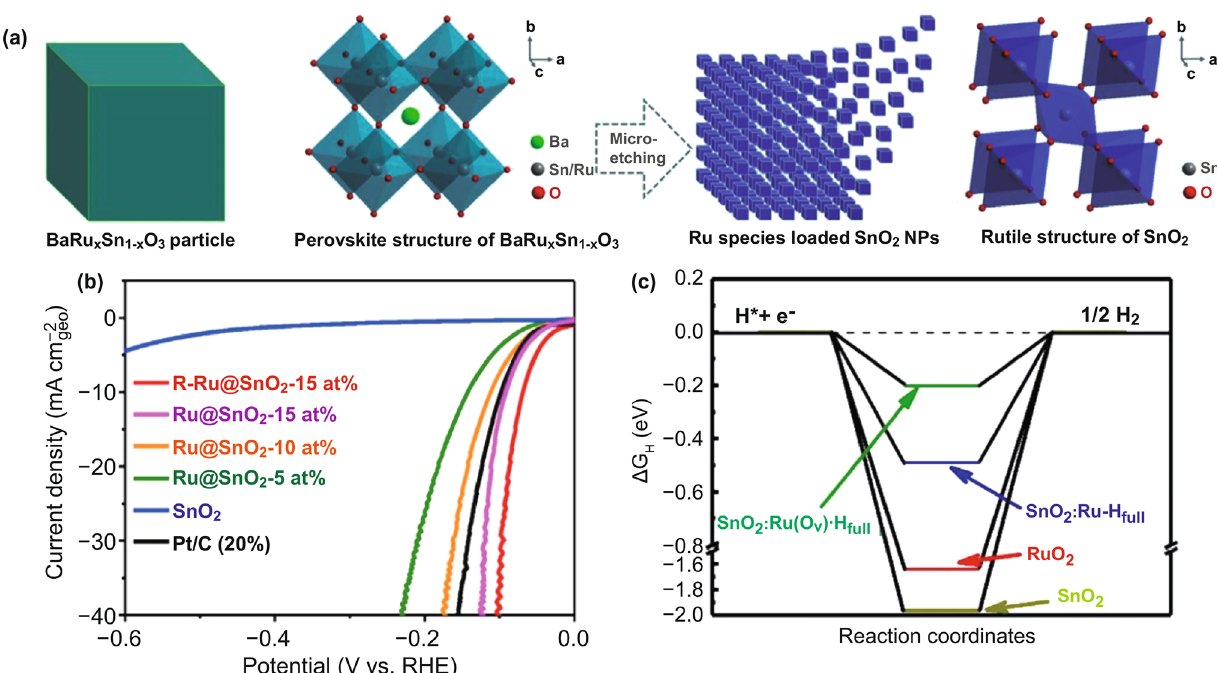
Fig. 5 a Schematic illustration of the synthetic strategy of Ru@SnO 2 . b Polarization curve of Ru@SnO 2 at 0.1 M KOH. c HER energy diagram [73], with permission from the Cell Press